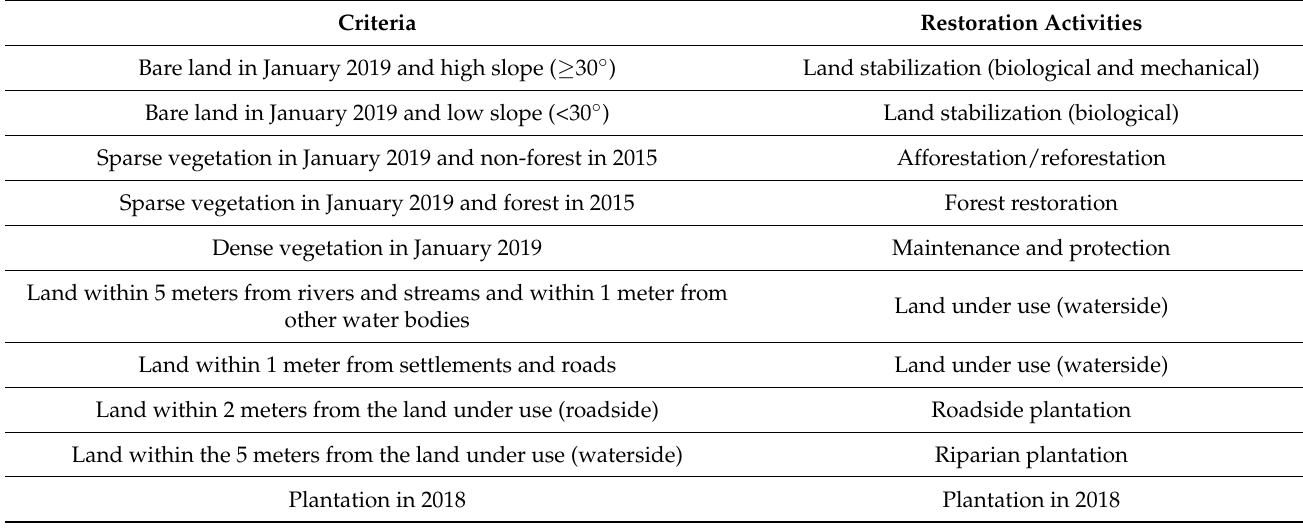
Table 4. Criteria for land suitability analysis inside the camps in 2019.